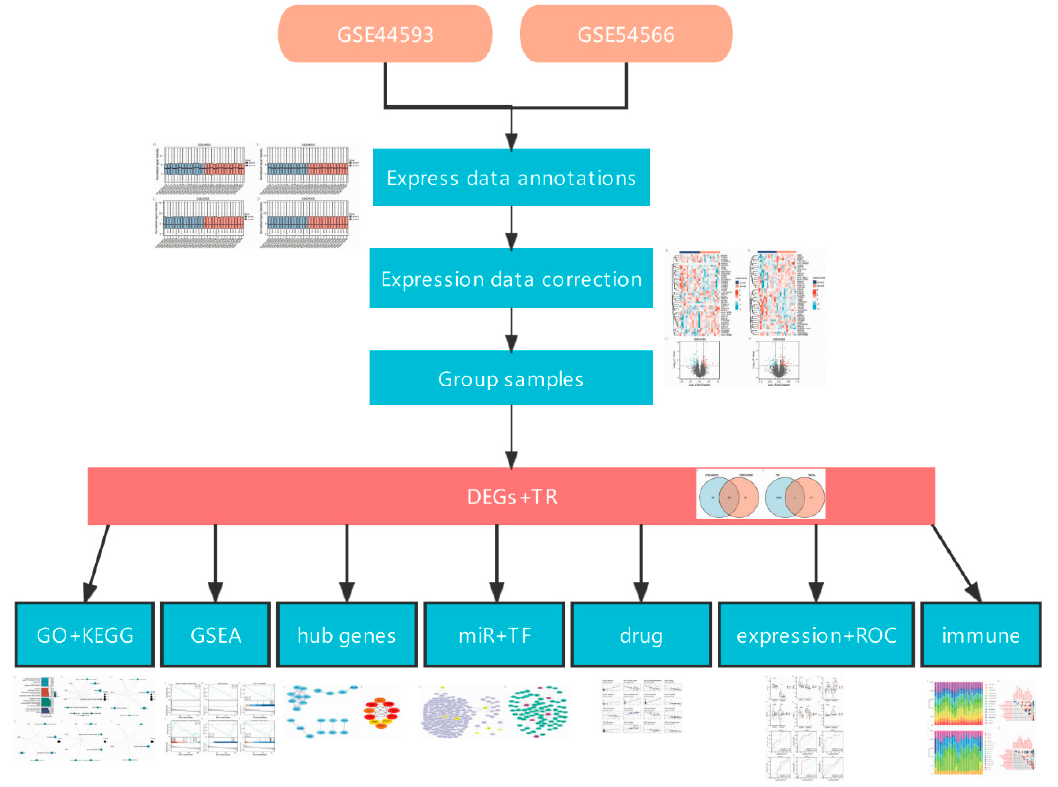
Figure 11. Demonstrates the workflow of the research